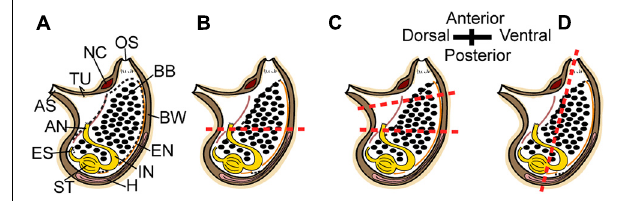
FIGURE 1 | Regeneration experiment. (A–D) Scheme of P. mytiligera adult (right view). (B) amputation at a single level along the AP body axis. (C) Amputation at two levels along the AP body axis. (D) amputation at a single level along the DV body axis. The red dotted line indicates amputation level. Anus (AN), atrial siphon (AS), branchial basket (BB), body wall (BW), endostyle (EN), esophagus (ES), heart (H), intestine (IN), neural complex (NC), oral siphon (OS), stomach (ST), and tunic